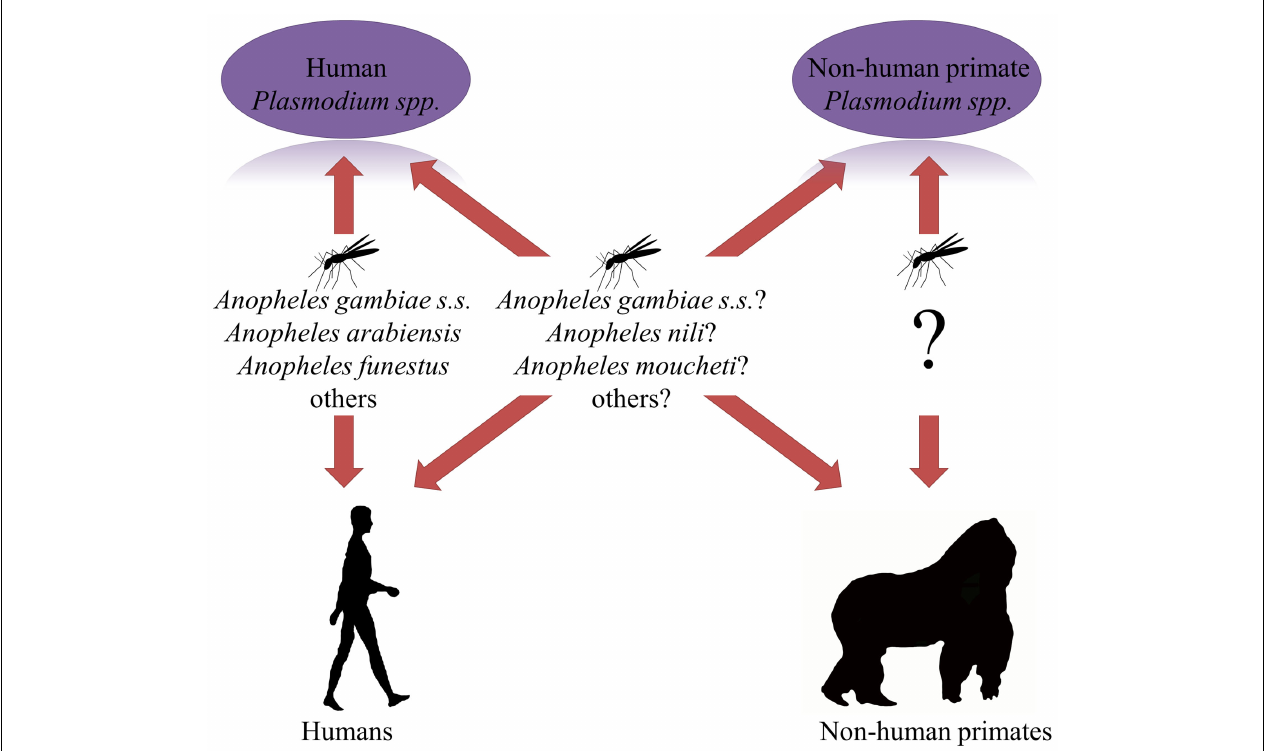
FIGURE 1 | Interactions between mosquitoes, their hosts, and human and non-human primate Plasmodium species inAfrica. Question marks indicate unidentified vectors.